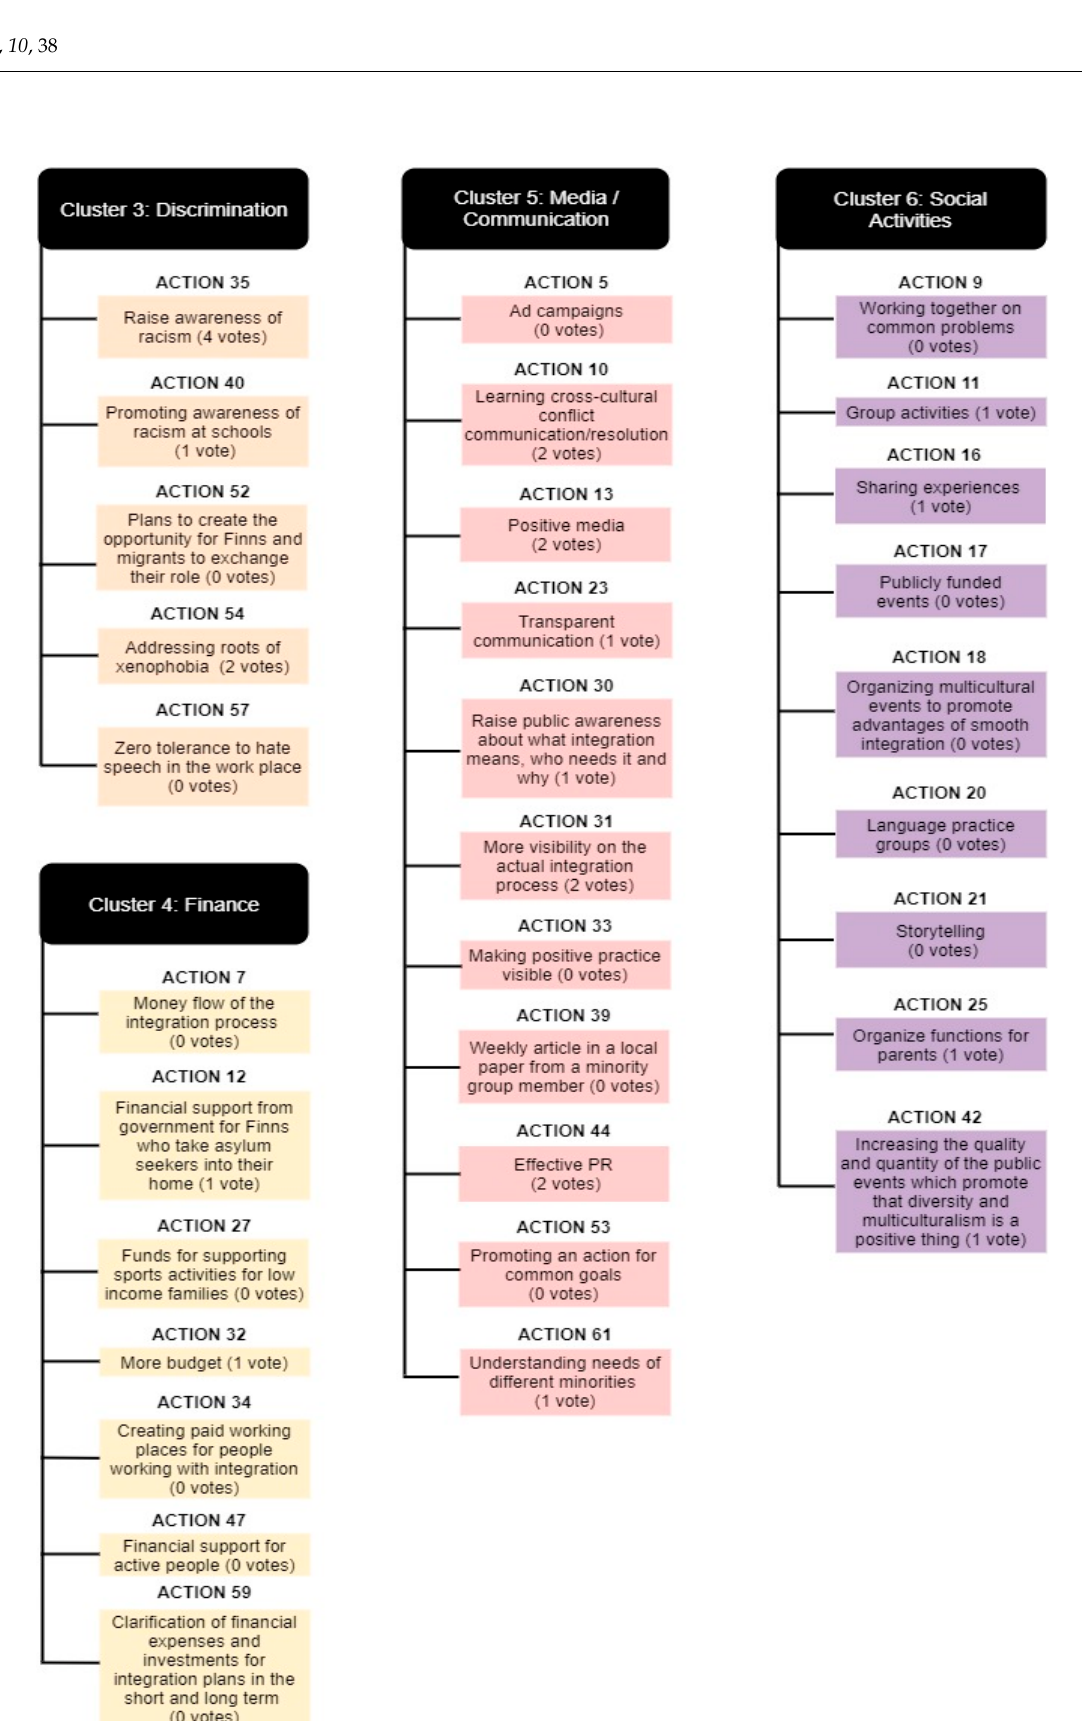
Figure 3. Clusters 3–6 of the proposed actions.